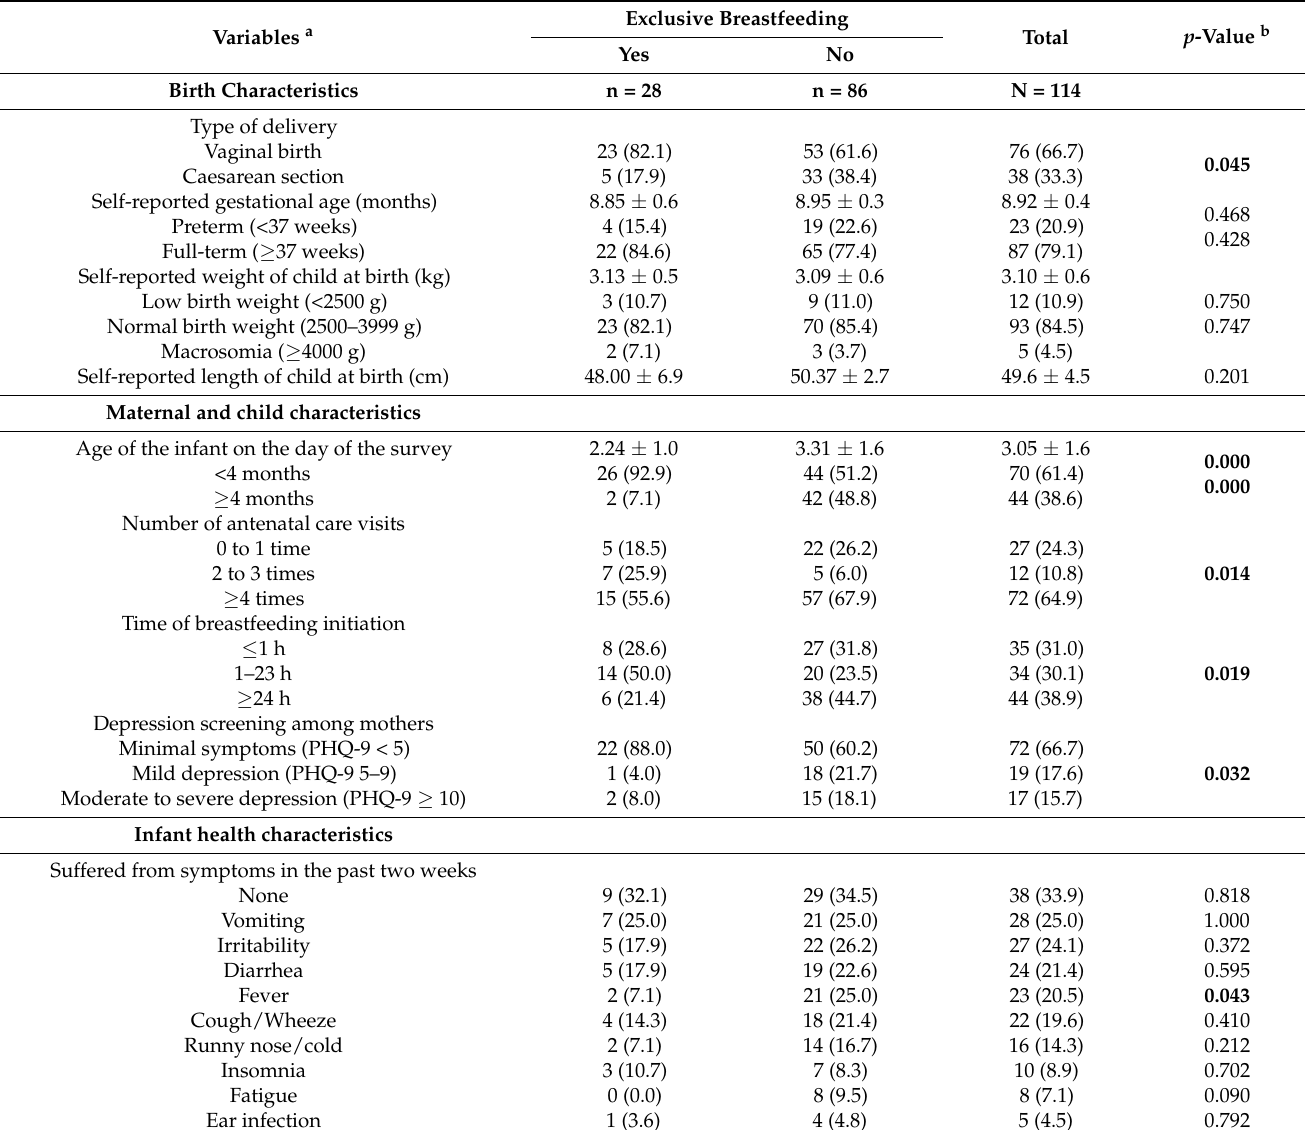
Table 3. Maternal, birth, health characteristics, anemia, and nutritional status of infants under six months by exclusive breastfeeding status among Syrian refugees in Greater Beirut,